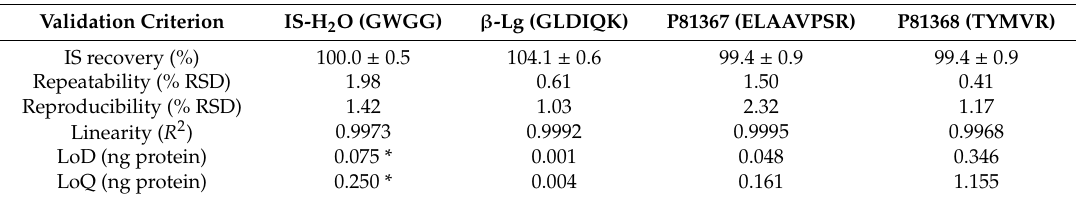
Table 2. Summary of method validation results. For ATIs P81367 and P81368, the results from cultivar SOR 958 are